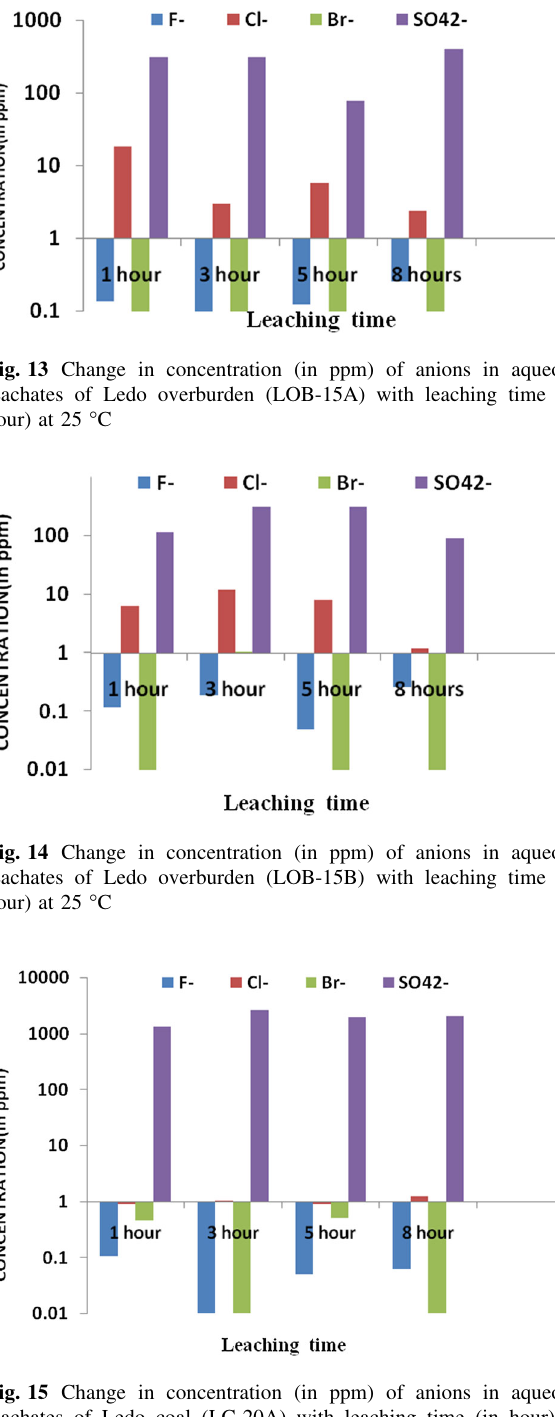
Fig. 15 Change in concentration (in ppm) of anions in aqueous leachates of Ledo coal (LC-20A) with leaching time (in hour) at 45 (cid:3) C